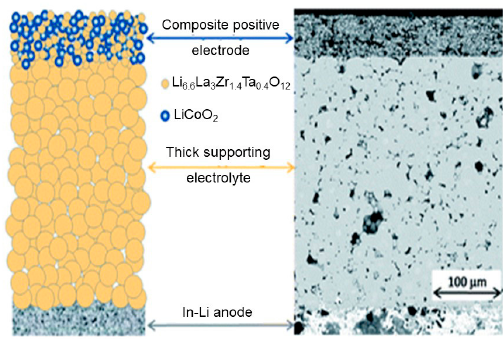
Figure 1. Schematicdiagramofthefabricatedelectrolyteforall-solid-stateLibatteriesanditscross-sectional Figure 1. Schematic diagram of the fabricated electrolyte for all-solid-state Li batteries and its scanning electron micrograph. Reproduced with permission from [13]. Copyright 2018 Royal Society cross-sectional scanning electron micrograph. Reproduced with permission from [13]. Copyright of 2018 Royal Society of Chemistry.